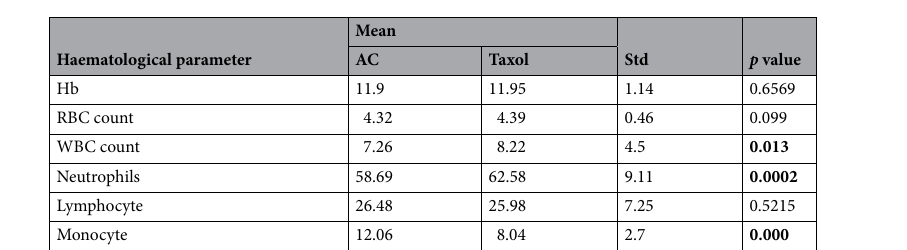
Haematological parameter